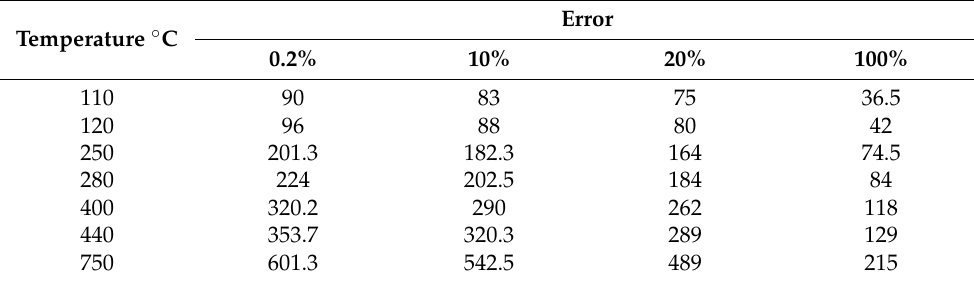
Table 1. Values of “error” for nozzle temperature in the range from 25 to 750 ◦ C and fixed power consumption of 0.2, 10, 20, 100%.